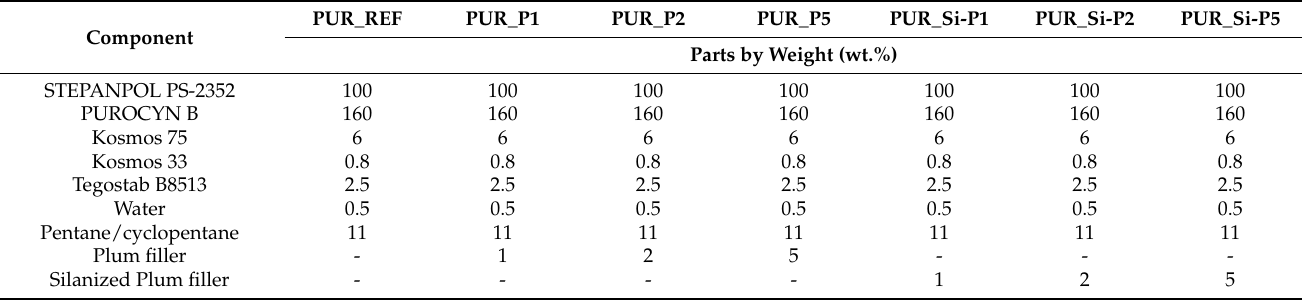
Table 3. Composition of polyurethane